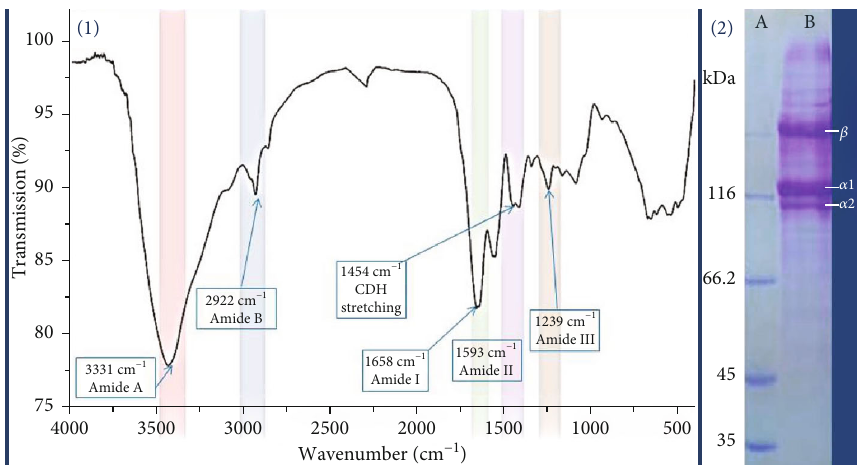
Figure 1: FTIR spectrum (1) and SDS-PAGE electrophoresis pattern (2) of fi sh collagen produced from Spondyliosoma cantharus.